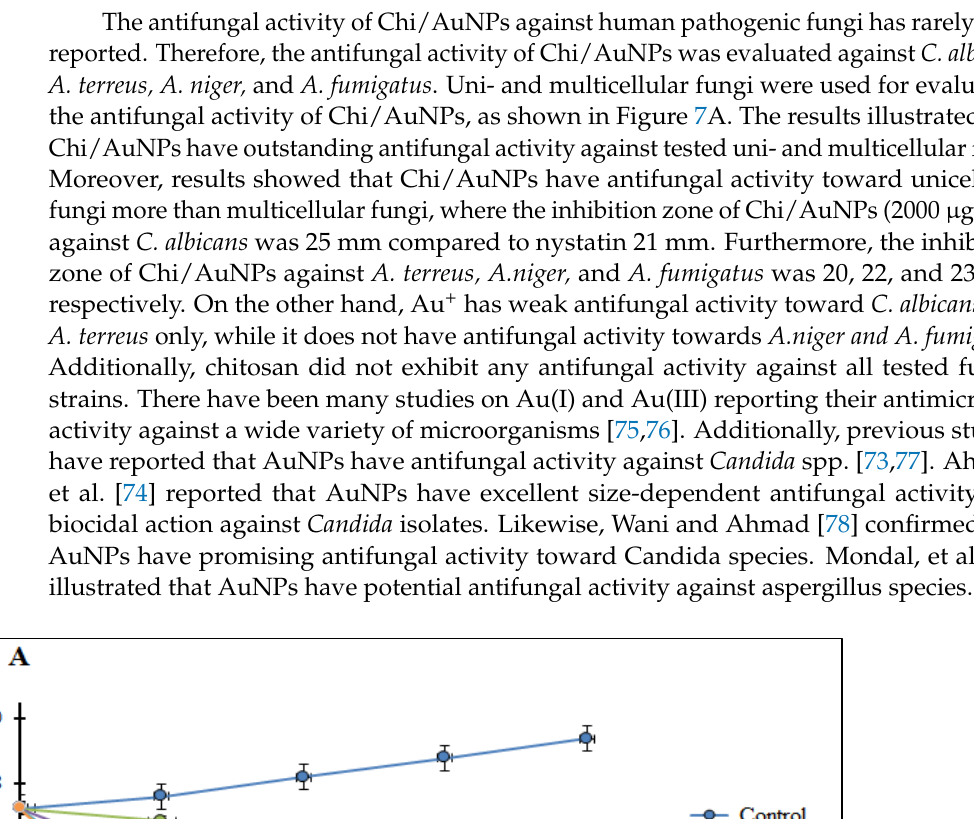
Table 1. Inhibition zones and MICs of Chi/AuNPs, chitosan, HAuCl 4 .3H 2 O, and ciprofloxacin.